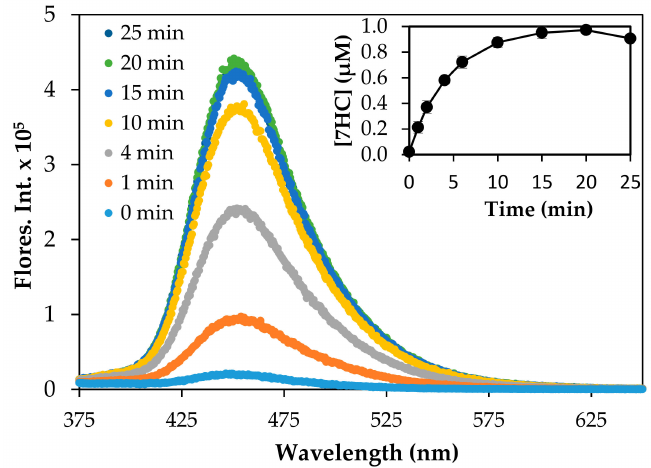
Figure 6. Change of fluorescence intensity observed at 455 nm during the irradiation of P25 TiO 2 (0.10 g / L) suspended in a 125 µ M COU aqueous solution. The plot of 7HC vs irradiation time is shown in the inset. The irradiation of P25 TiO 2 suspension was carried out at 350